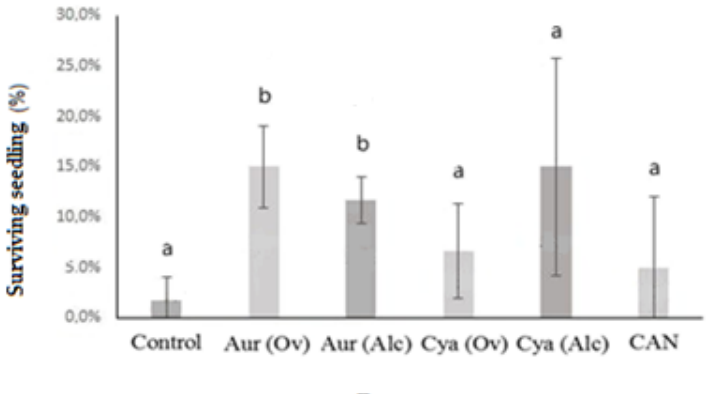
Figure 4. The proportion of surviving seedlings (as percent) among the different treatments in the pot experiment. Error bars represent the ± standard deviation. Welch test in two pairs only with control. Same letters indicate differences are non-significant with control.